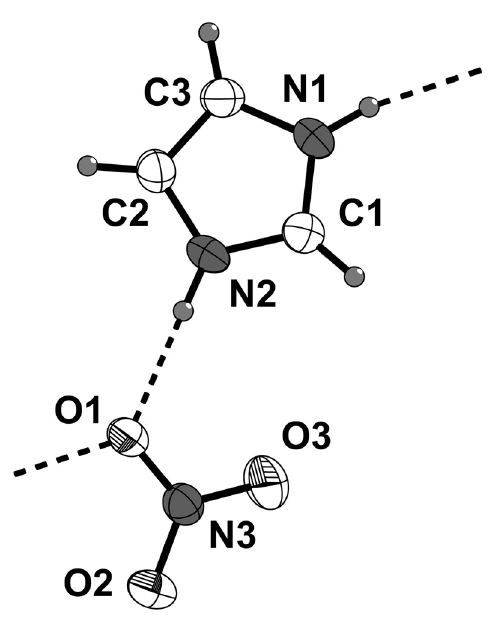
Table  : Data collection and